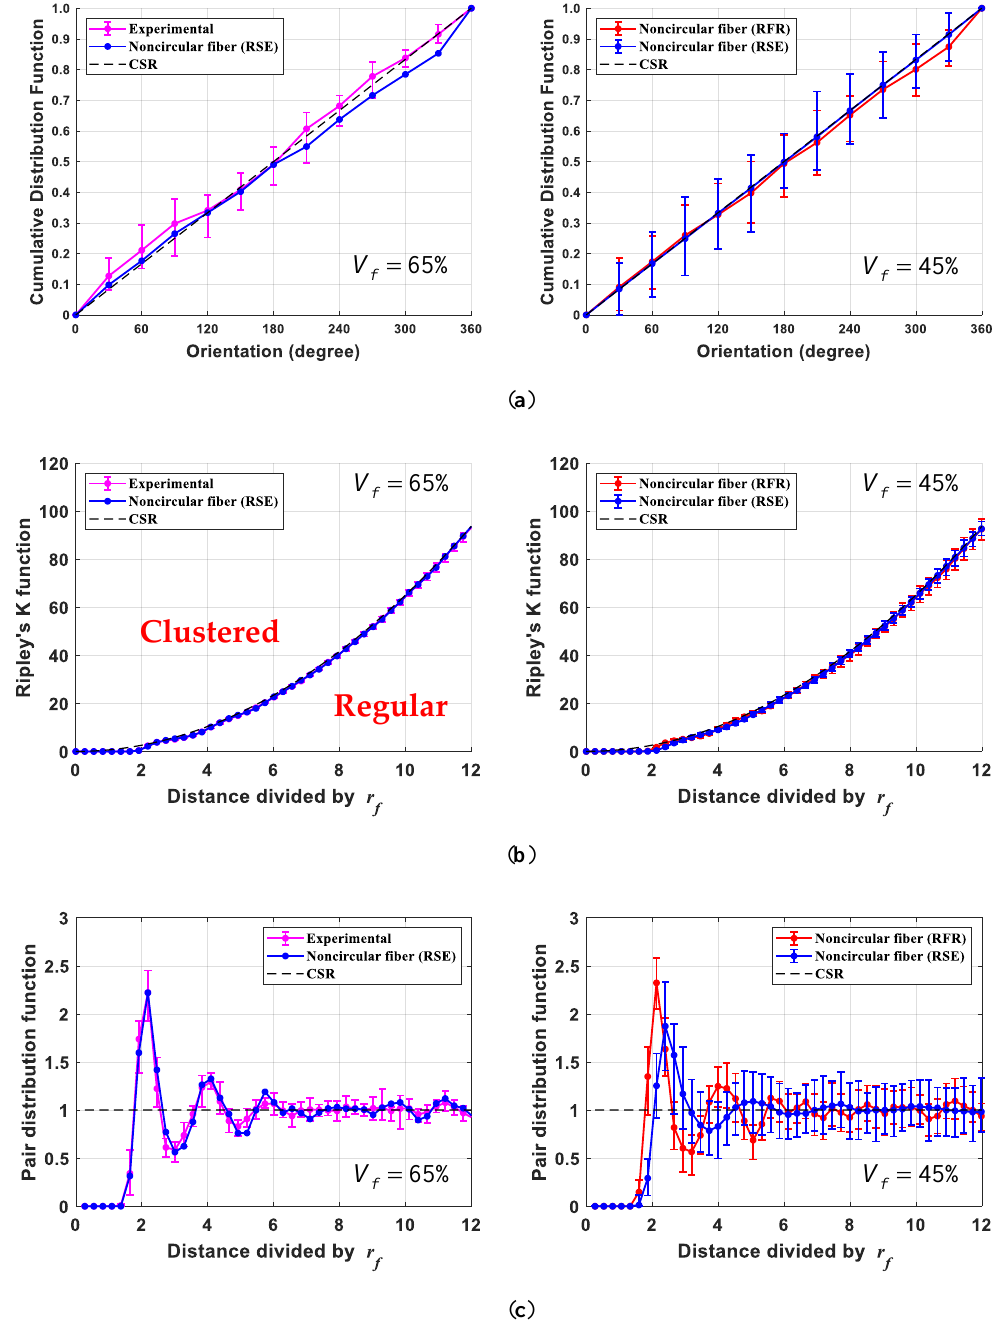
Figure 5. Comparison of statistical spatial metrics of RVEs: ( a ) nearest neighbor orientation, ( b ) Ripley’s K function , and ( c ) pair distribution function.